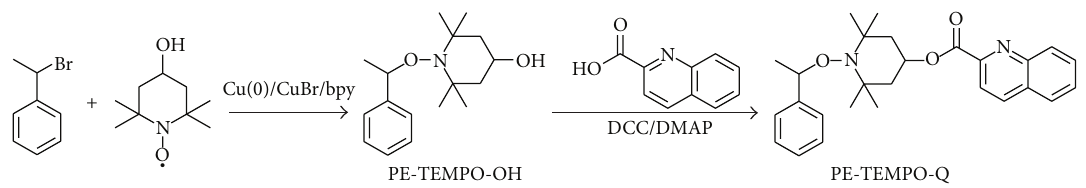
Scheme 1: Synthesis of photosensitive alkoxyamine PE-TEMPO-Q.